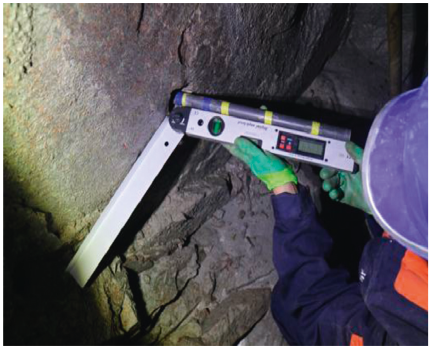
Figure 8: Geometric measurement of the drilling hole using a graduated stick.